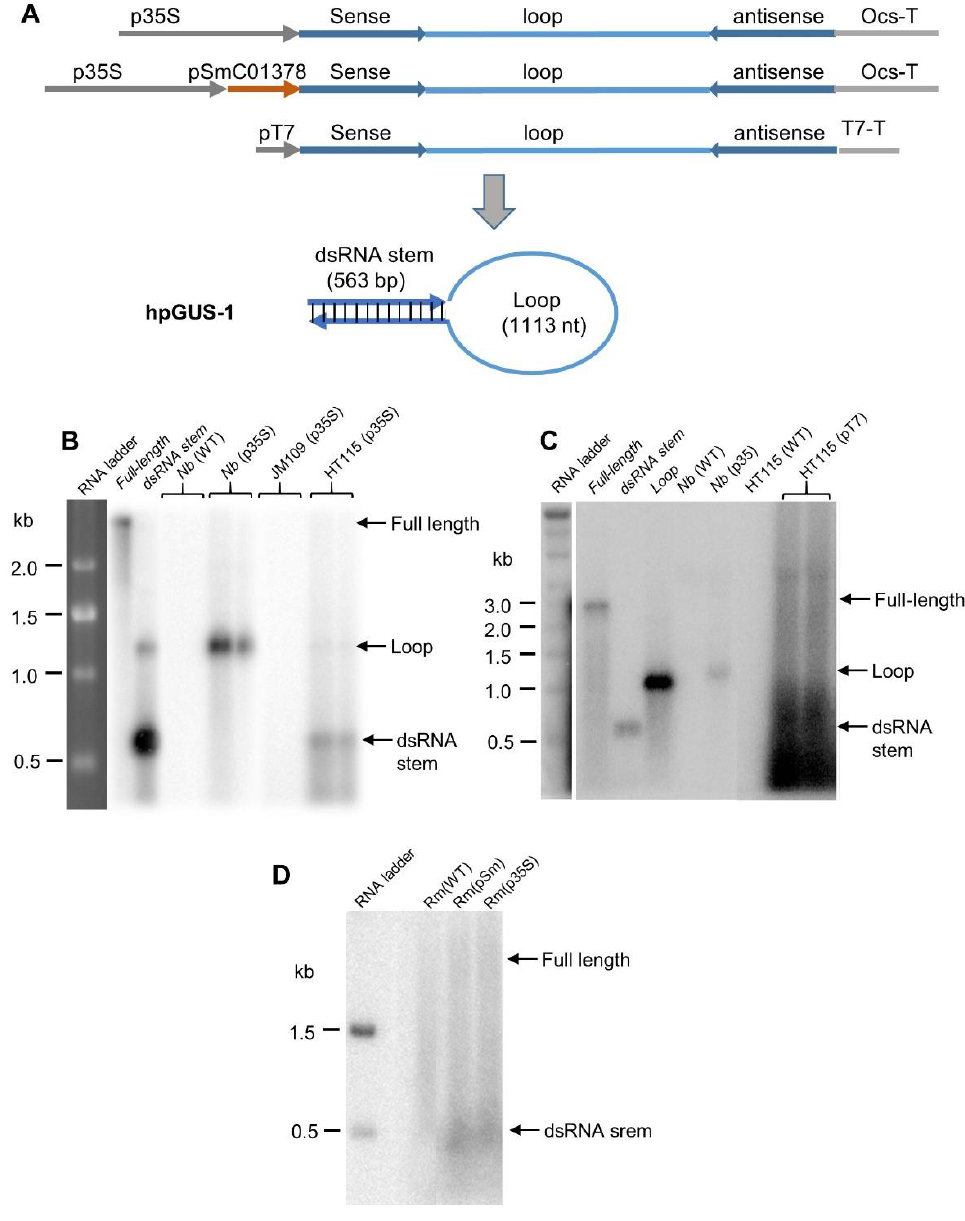
Figure1. LonghpRNAexpressedinplantsandbacteriaisprocessedintoshortfragments. ( A ) Schematic of the β -glucuronidase (GUS) hpRNA constructs and predicted hpRNA structure. p35S and pSmC01378 are the cauliflower mosaic virus 35S RNA promoter and Sinorhizobium meliloti tRNA promoter, respectively. ( B ) Northern blot hybridization showing that GUS hpRNA expressed by the 35S promoter in Agrobacterium -infiltrated Nicotiana benthamiana (Nb) leaves and the RNase III-deficient Escherichia coli strain HT115 were processed into the loop or dsRNA stem. Eight micrograms of total RNA were separated in a 1.3% formaldehyde agarose gel, transferred to a Hybond-N membrane, and hybridized with 32 P-labeled full-length antisense GUS RNA. Almost no signals were detected in the wild-type E. coli strain JM109 background, confirming the advantages of HT115 for dsRNA accumulation. ( C ) GUS hpRNA expressed by the T7 polymerase promoter in E. coli HT115 was processed into short RNA fragments. ( D ) GUS hpRNA expressed by two di ff erent promoters in Sinorhizobium meliloti (Sm) strains The “Full-length”, “Loop”, and “dsRNA Stem” in the left lanes of ( B , C ) are in vitro transcripts (50 ng each), where the dsRNA stem was prepared by annealing sense and antisense